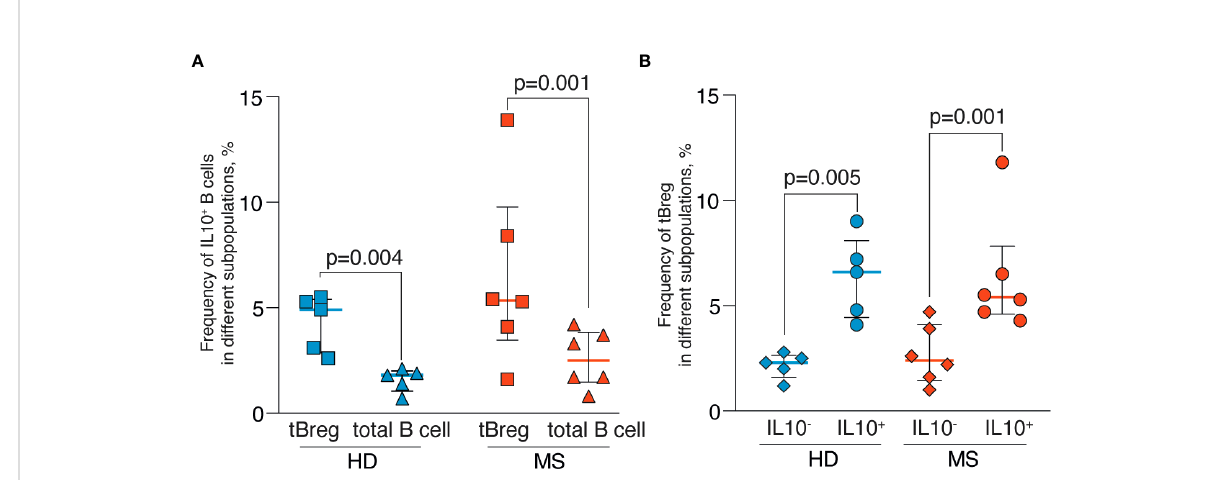
FIGURE 5 Frequencies of the IL-10 – positive B cells in peripheral blood of MS patients and healthy individuals after rapid CpG stimulation. (A) The percentage of IL-10 – positive cells in CD19 + CD24 high CD38 high tBreg subpopulation and total B cells. (B) The percentage of CD19 + CD24 high CD38 high tBreg in IL- 10 – positive and IL-10 – negative B cells. Results are expressed as a median, interquartile range, and p -values analyzed by ratio paired T -test. Statistical signi fi cance of the differences between donor groups was assessed by the Mann Whitney test, and signi fi cance of differences between B cell subpopulations was assessed by the ratio paired T -test. Statistically signi fi cant p -values ( p <.05) are